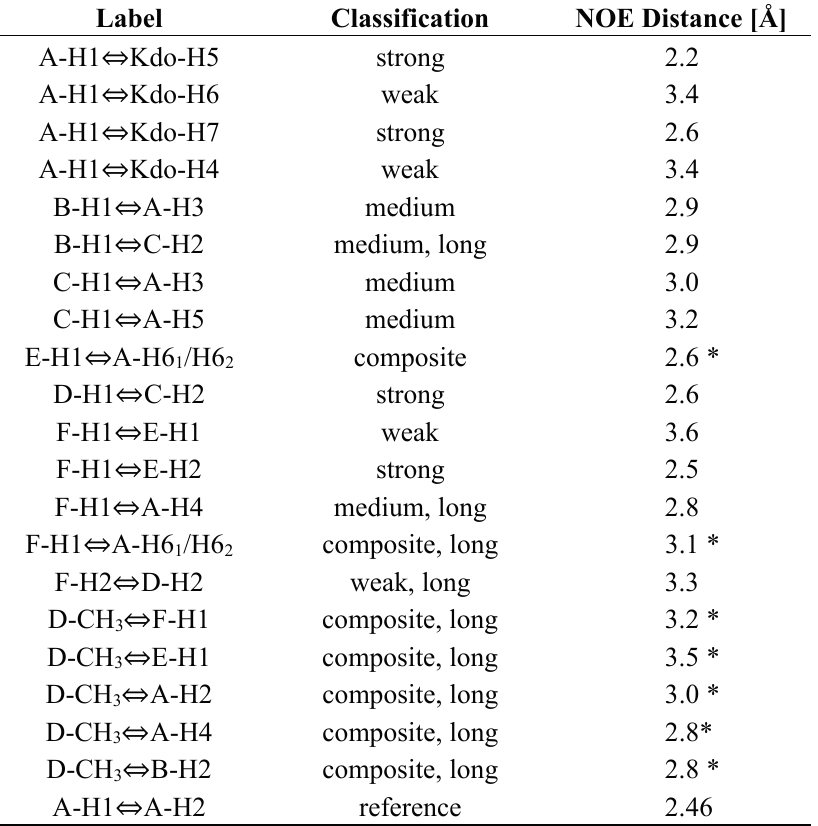
Table 3. Inter-residue NOE data obtained for lgt2 Δ OS. Distance constraints used for classification: strong 1.8–2.8 Å, medium 1.8–3.3 Å and weak 1.8–5.0 Å. The effective H-H distance r NOE was calculated from the peak integral I using equation r NOE = r ref ( I ref / I ) 1/6 . * Virtual NOE distance, multiple H-H pairs